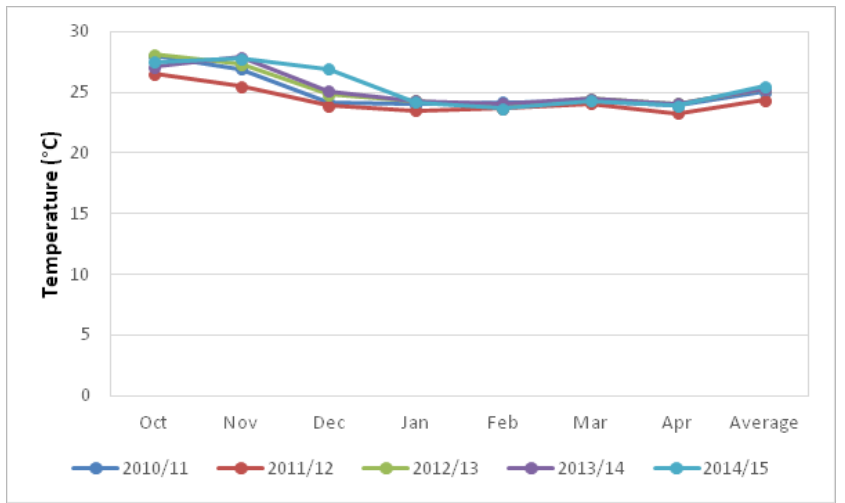
Figure 4: Maximum temperatures recorded in five seasons (2010-2015)